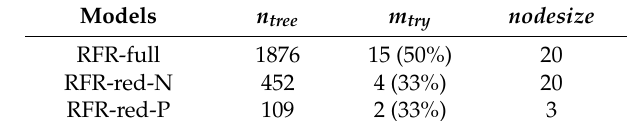
Table 2. The optimal hyperparameter configurations of the RFR models.